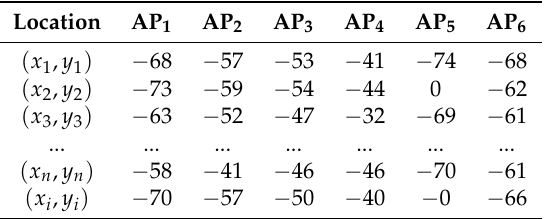
Table 2. The sequence of